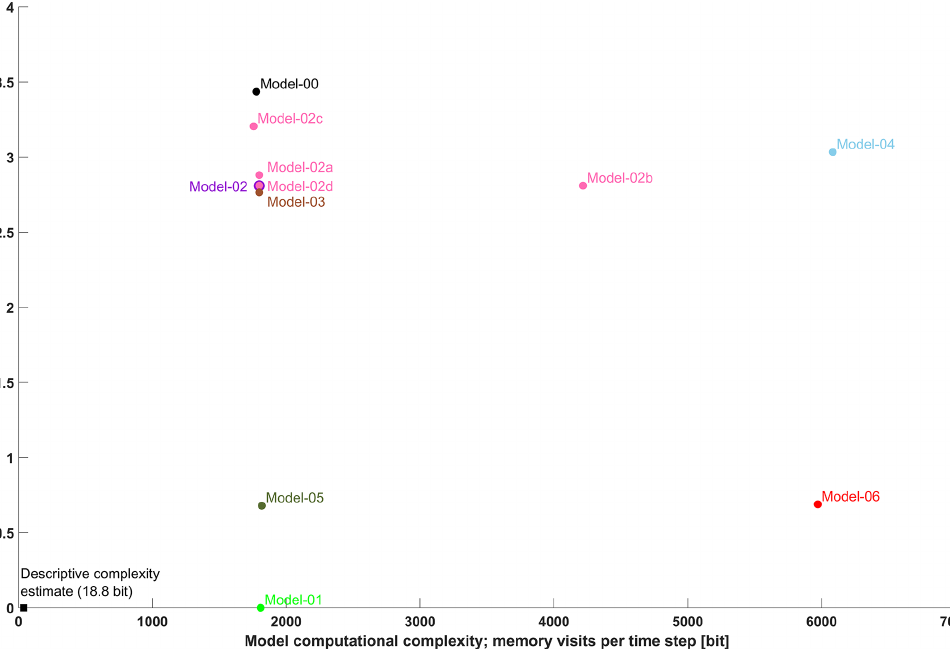
Figure 4. Model performance expressed by its inverse, information loss per time step, measured by conditional entropy in bits vs. model computational complexity measured by the average number of memory visits per time step in bits for Model-00 to